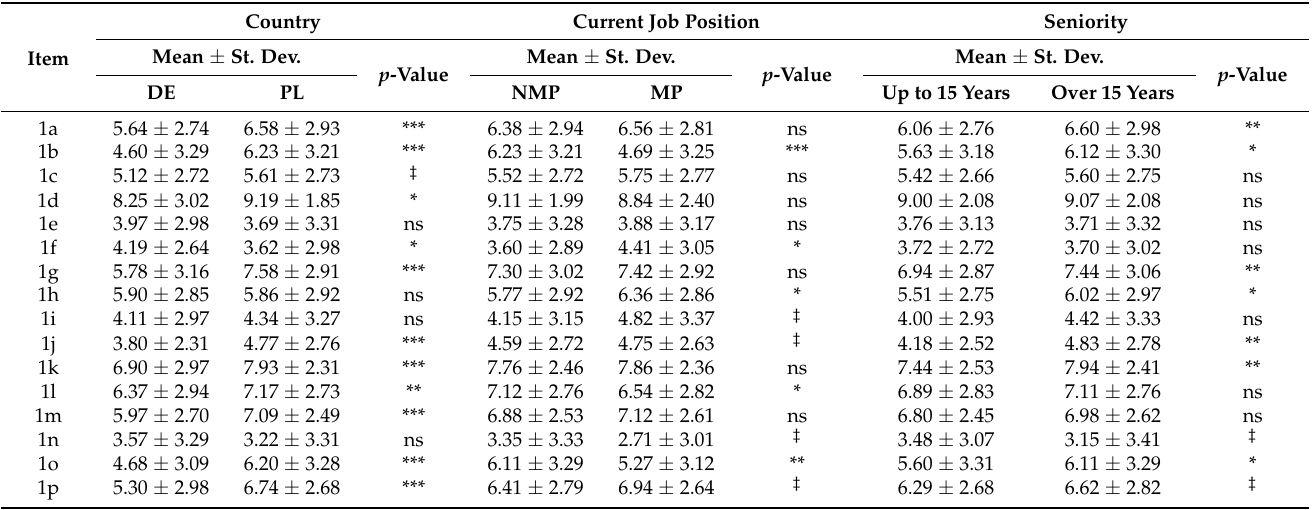
Table 2. Diversification of opinions concerning work in the nursing profession due to selected characteristics of the respondents. Country Current Job Position Seniority Mean ± St. Dev. Mean ± St. Dev. Item p -Value